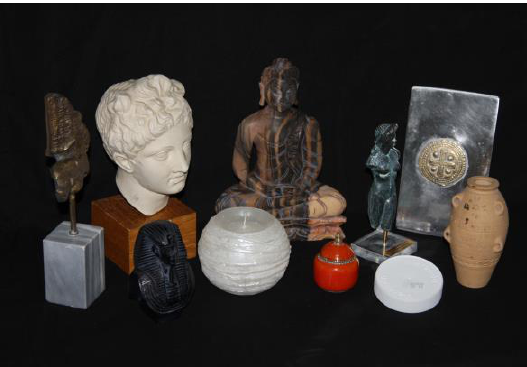
Figure 1: The collection of different artifacts tested (from left to right: Brass, Marble, Plaster, Mahogany, Wax, Wood, Porcelain, Bronze, Plastic, Metal,